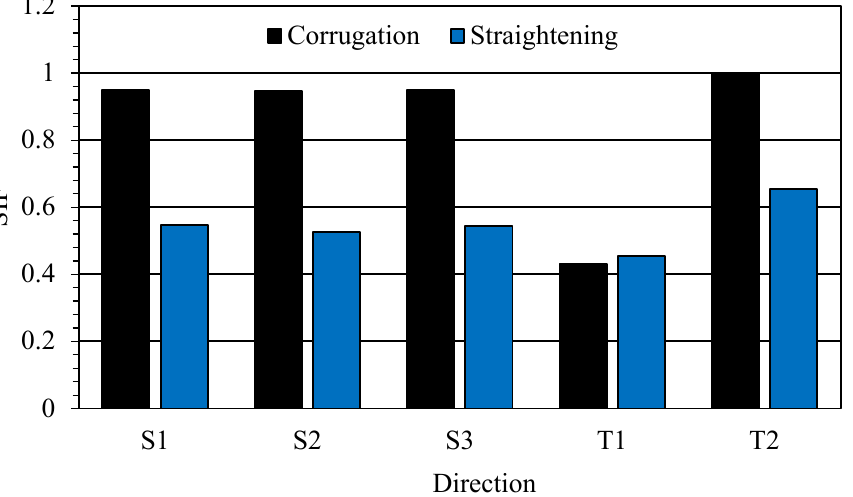
Figure 6. Variations of SIF along five directions (S1, S2, S3, T1, and T2) for the corrugation and straightening steps of the first pass for modified-CSP.